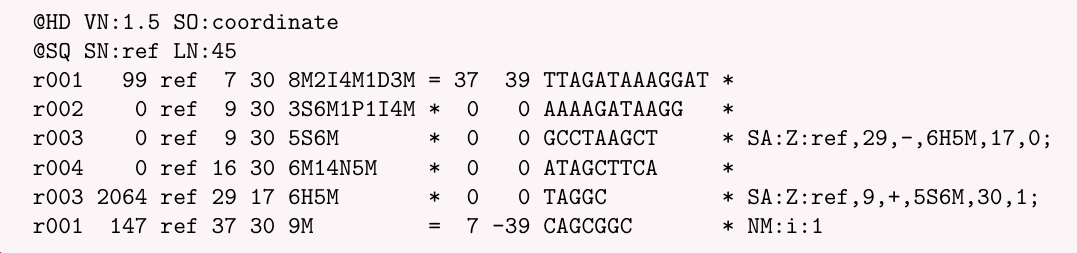
Figure 3. A sample of the SAM